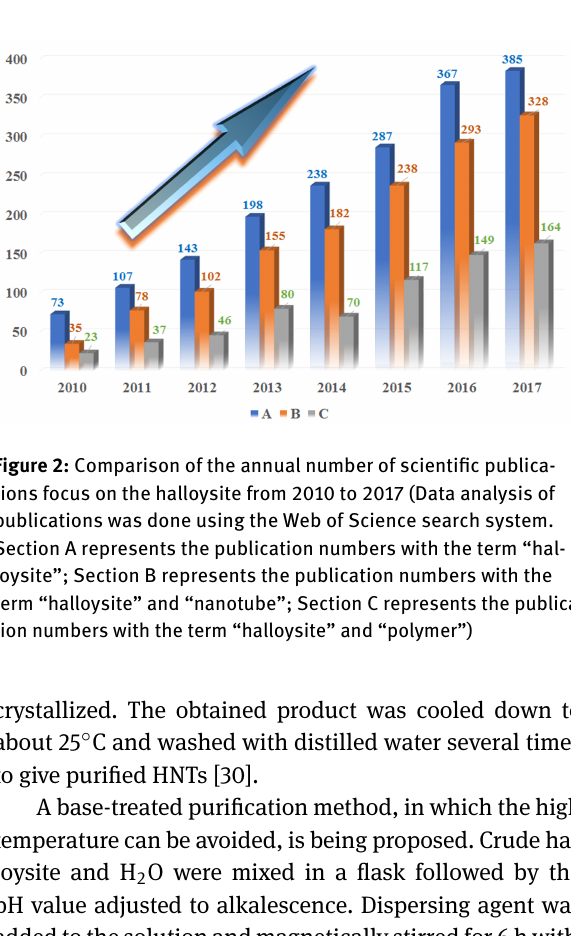
crystallized. The obtained product was cooled down to about 25 ∘ C and washed with distilled water several times to give purified HNTs